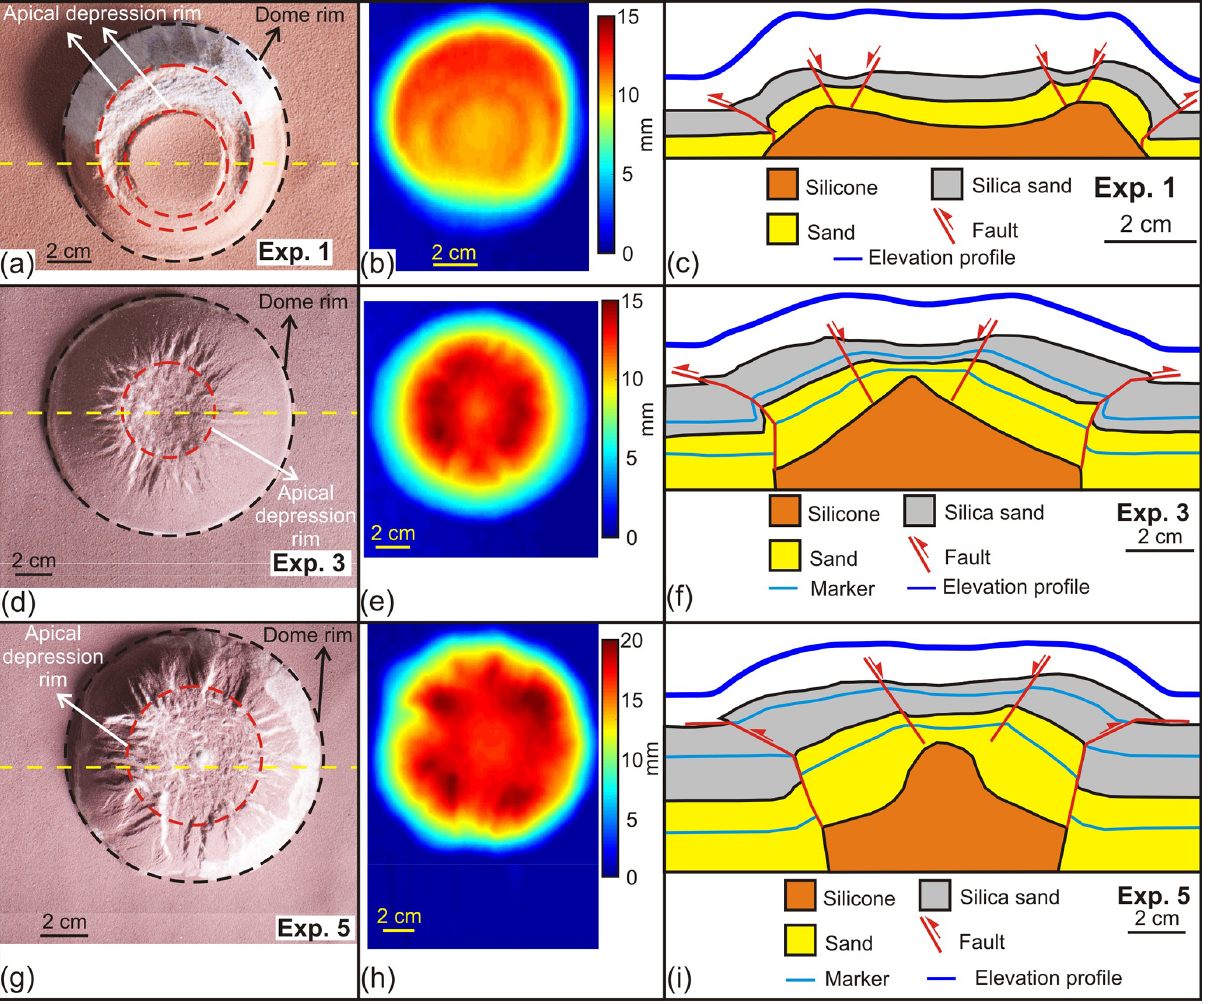
Figure 7. (a) , (d) , (g) Top view image of experiments 1, 3 and 5. (b) , (e) , (h) Cumulative vertical displacement; the colour scale is proportional to the amount of uplift. (c) , (f) , (i) Drawing of the cross section view obtained after cutting the section close to the dome centre. The elevation profiles are obtained from laser scanner data. The yellow dashed line in (a) , (d) and (g) indicates the trace of the section views and of the elevation